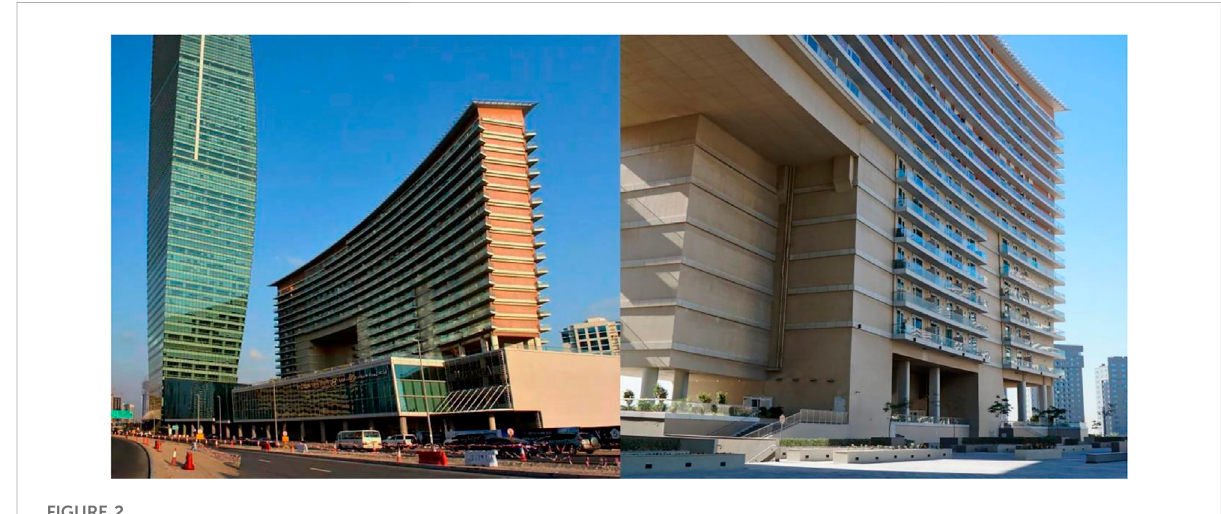
FIGURE 2 U-bora tower at business bay.